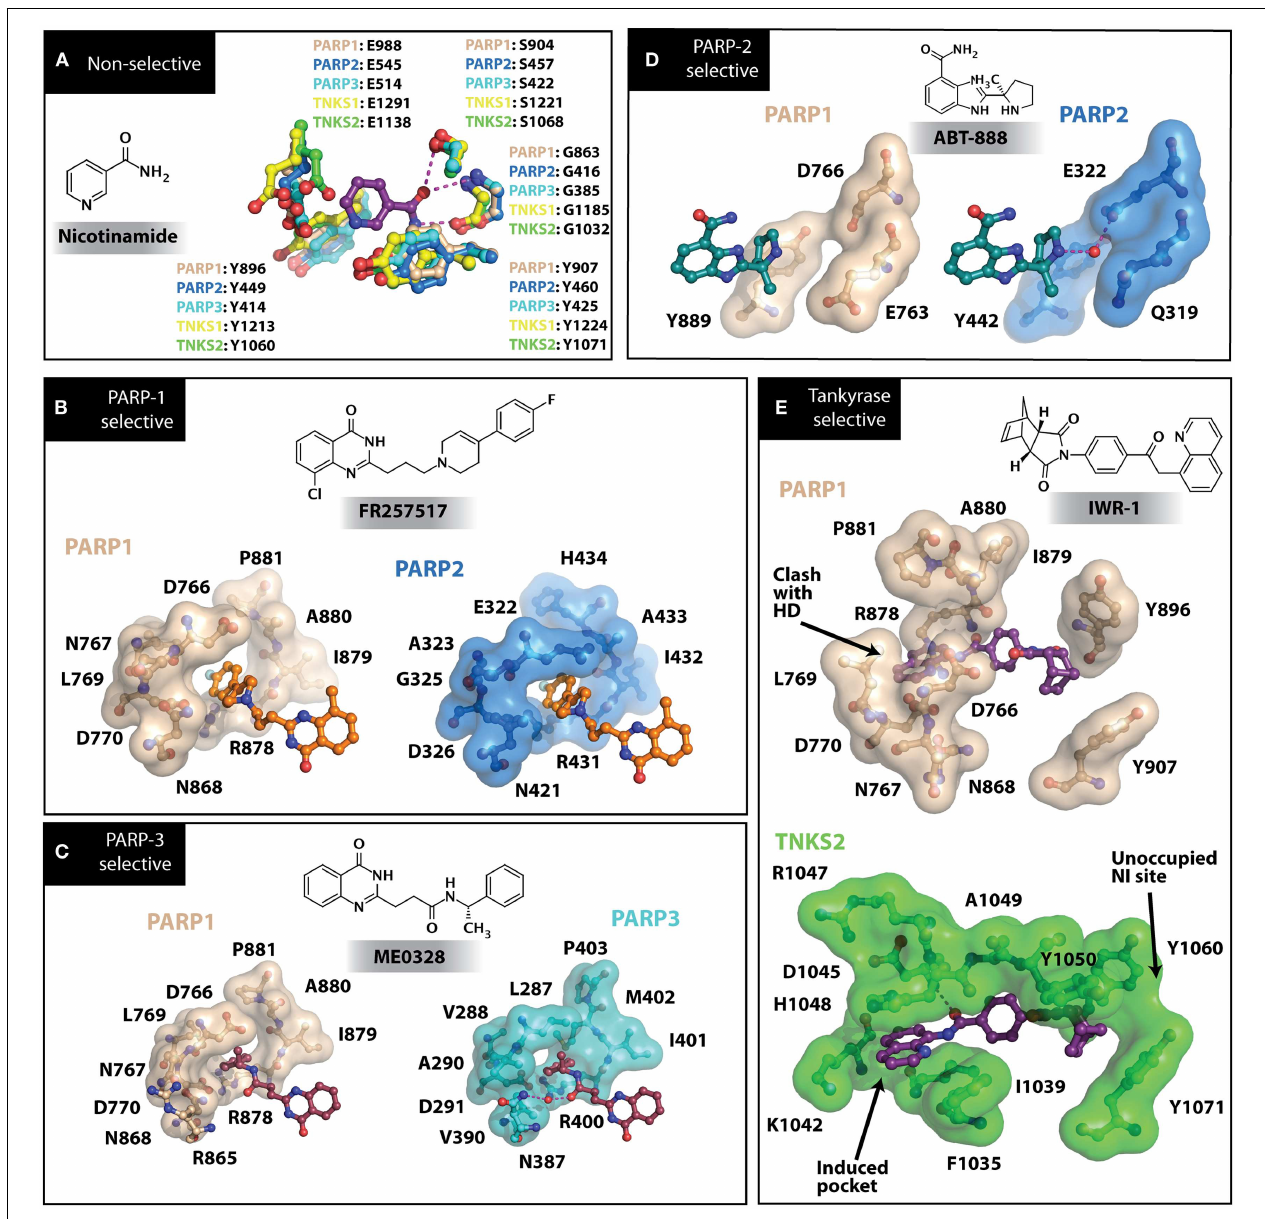
the differences in distance between this acidic side-chain and drug heteroatoms [ (D) , PARP-2 selective]. PARP-3 (PDB ID: 4GV4) has a structurally similar AD site as PARPs 1 and 2, although residue variation creates an environment distinct in polarity that guides selectivity [ (C) , PARP-3 selective].Tankyrase inhibitors often demonstrate a much higher window of selectivity from PARPs 1–4, although selectivity betweenTNKS1 andTNKS2 is difficult to obtain. IWR-1 is a non-traditional PARP inhibitor in that it does not target the nicotinamide site ofTNKS2 [ (E) ,Tankyrase selective]. PARP-1 (PDB ID: 1UK0) was aligned with the co-crystallizedTNKS2 structure containing IWR-1 (3UA9) to demonstrate that the quinoline ring clashes into the AD site of PARP-1 due to the presence of its helical